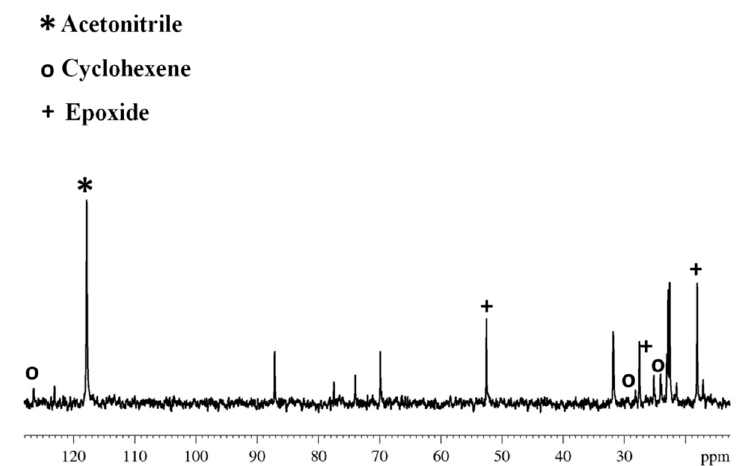
Figure 5. 13 C spectrum of the cyclohexene oxidation product using the ClNbS-AC catalyst. Spectrum acquired at room temperature on a 400 MHz spectrometer.